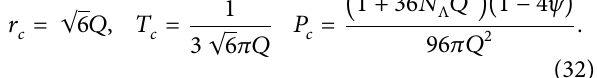
Figure 4: The 𝑃 − 𝑇 diagram of four-dimensional charged AdS black holes with 휔 solid line initiating from (푃 The solid line commencing from (푃 indicating the